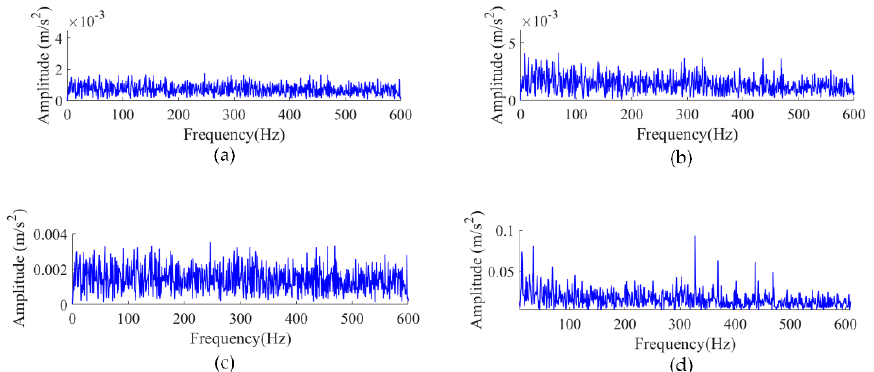
Figure 12. Denoising the 50th minute signals envelope spectra of 4 different methods. ( a ) L1-kurtosis, ( b ) RSVD, ( c ) VMD, and ( d ) SRSVD.